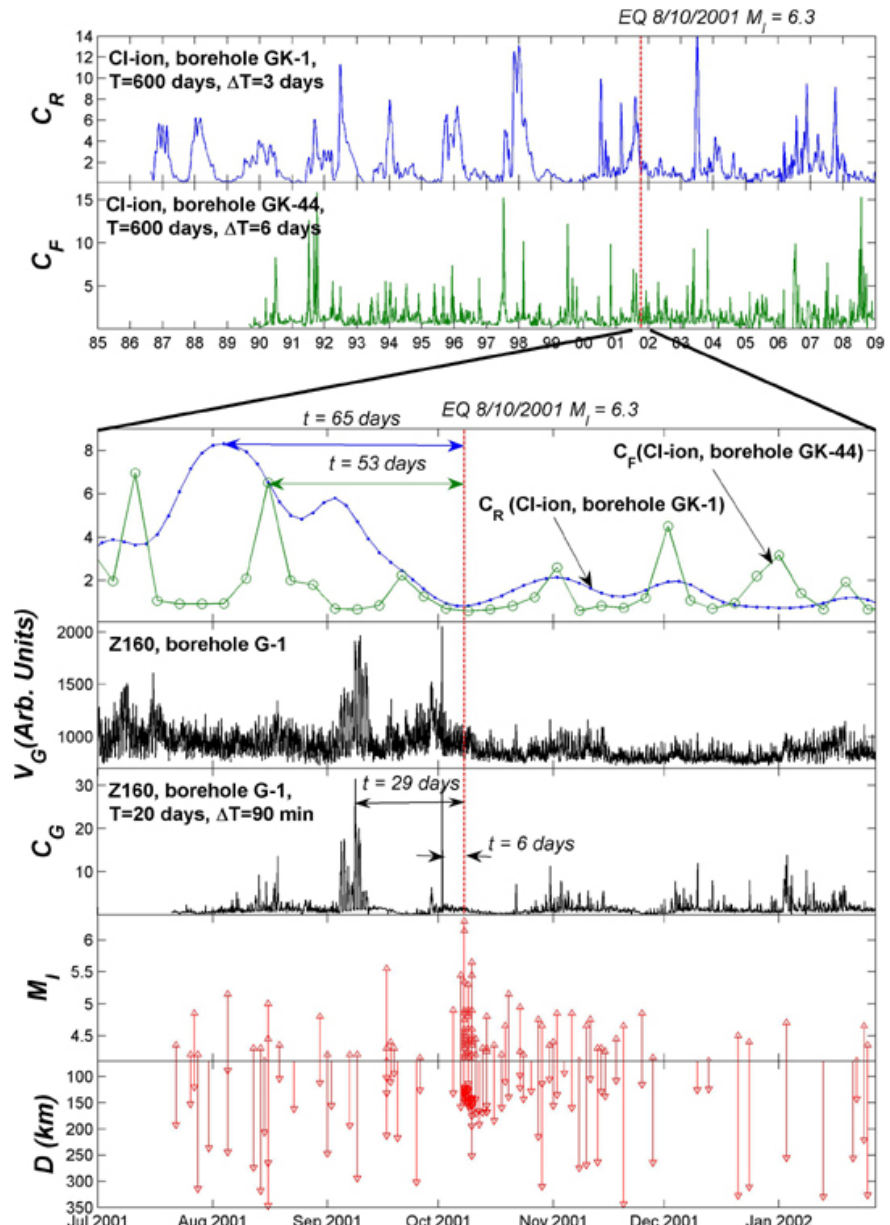
Fig. 4. Nonstationarity factors for GK-1 and GK-44 chlorine-ion concentrations and Z160 G-1 geoacoustic emissions in a time frame around the 8 October 2001 earthquake. M l – local earthquake magnitude, D – distance from the epicenter. The double-headed arrows denote the time intervals between the nonstationarity factor spikes and earthquake